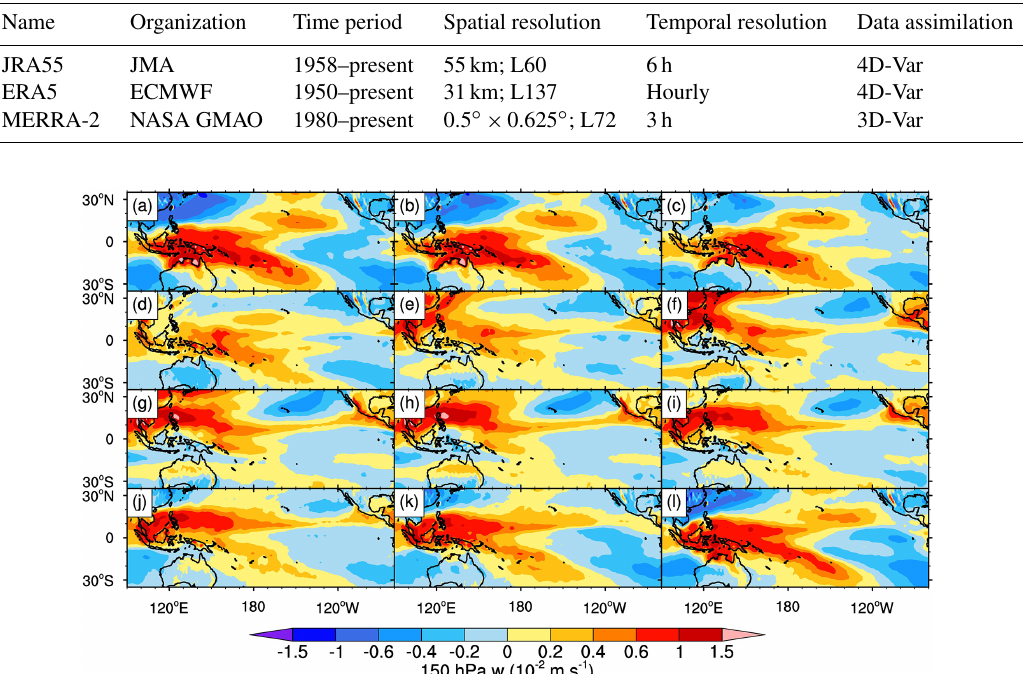
Figure 1. The climatological mean (averaged over 1958–2017) values of 150hPa w (10 − 2 ms − 1 ) in January–December (a–l) , as derived from the JRA55